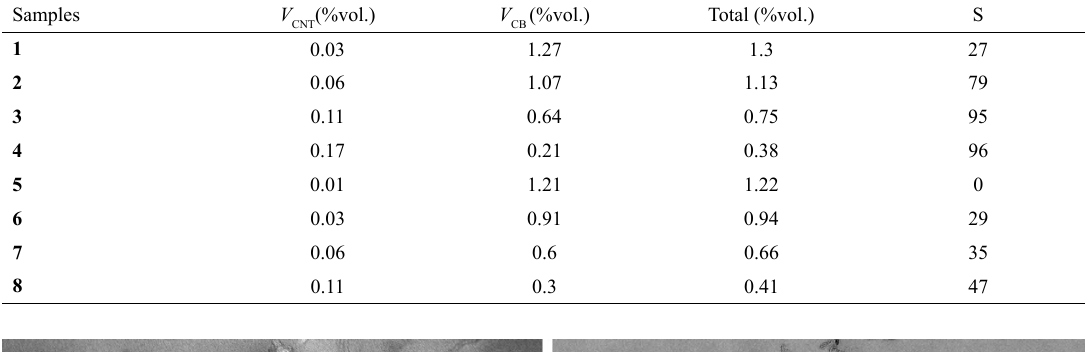
Table 5. Percolation Success (S) of 100 simulations for hybrid nanocomposites. Samples V